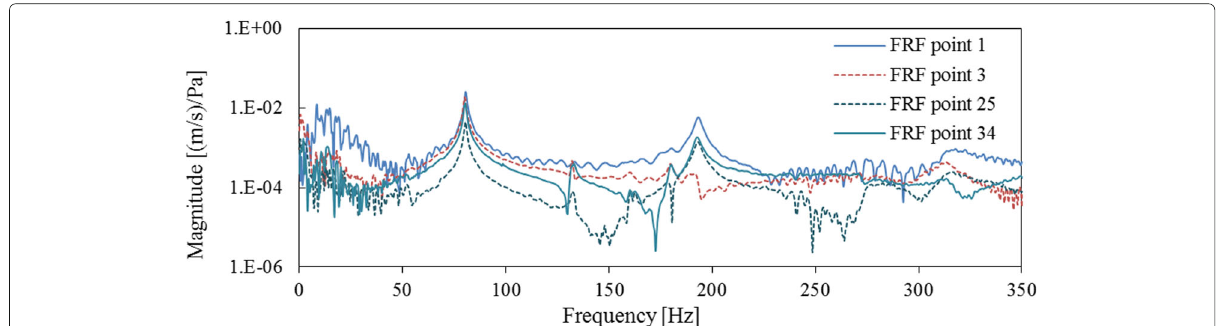
Fig. 14 Impedance FRFs for four response measurements during EMA of the